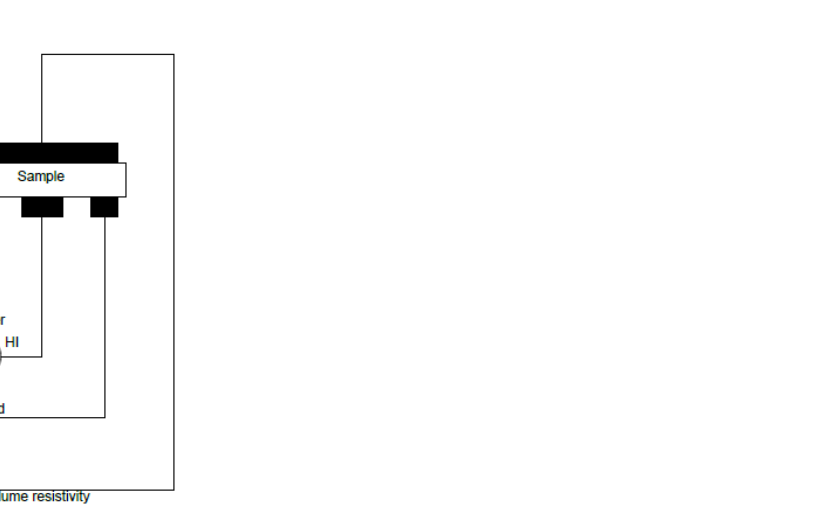
Figure 4. Diagram of the volume resistivity measurement technique.